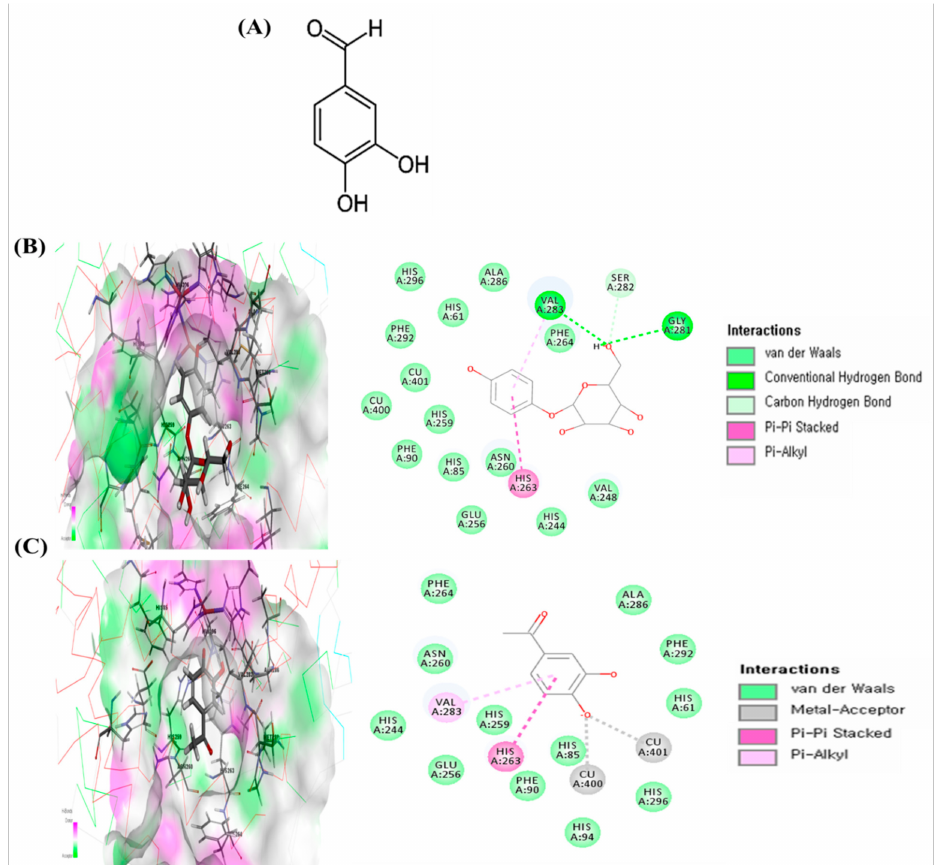
Figure 1. Chemical structure of protocatechuic aldehyde (PA) ( A ) and the specific interactions between PA and tyrosinase after automated docking of PA to the tyrosinase enzyme binding site. Predicted 3D structure of the tyrosinase (Protein Data Bank; PDB code: 2Y9X)–arbutin complex and 2D diagram ( B ). Predicted 3D structure of the tyrosinase (PDB 2Y9X)–PA complex and 2D diagram ( C ). Binding energy values were obtained from the Discovery Studio (DS) 3.0 binding energy calculation